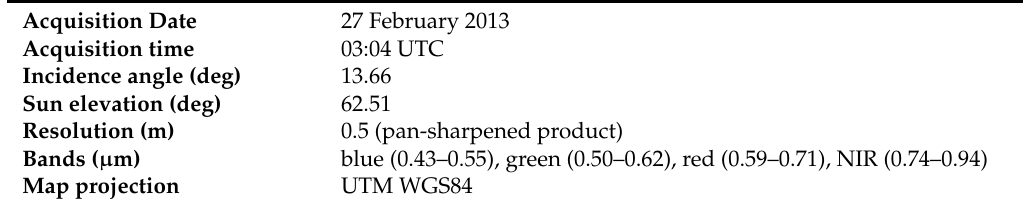
Table 1. The characteristics of Pleiades image